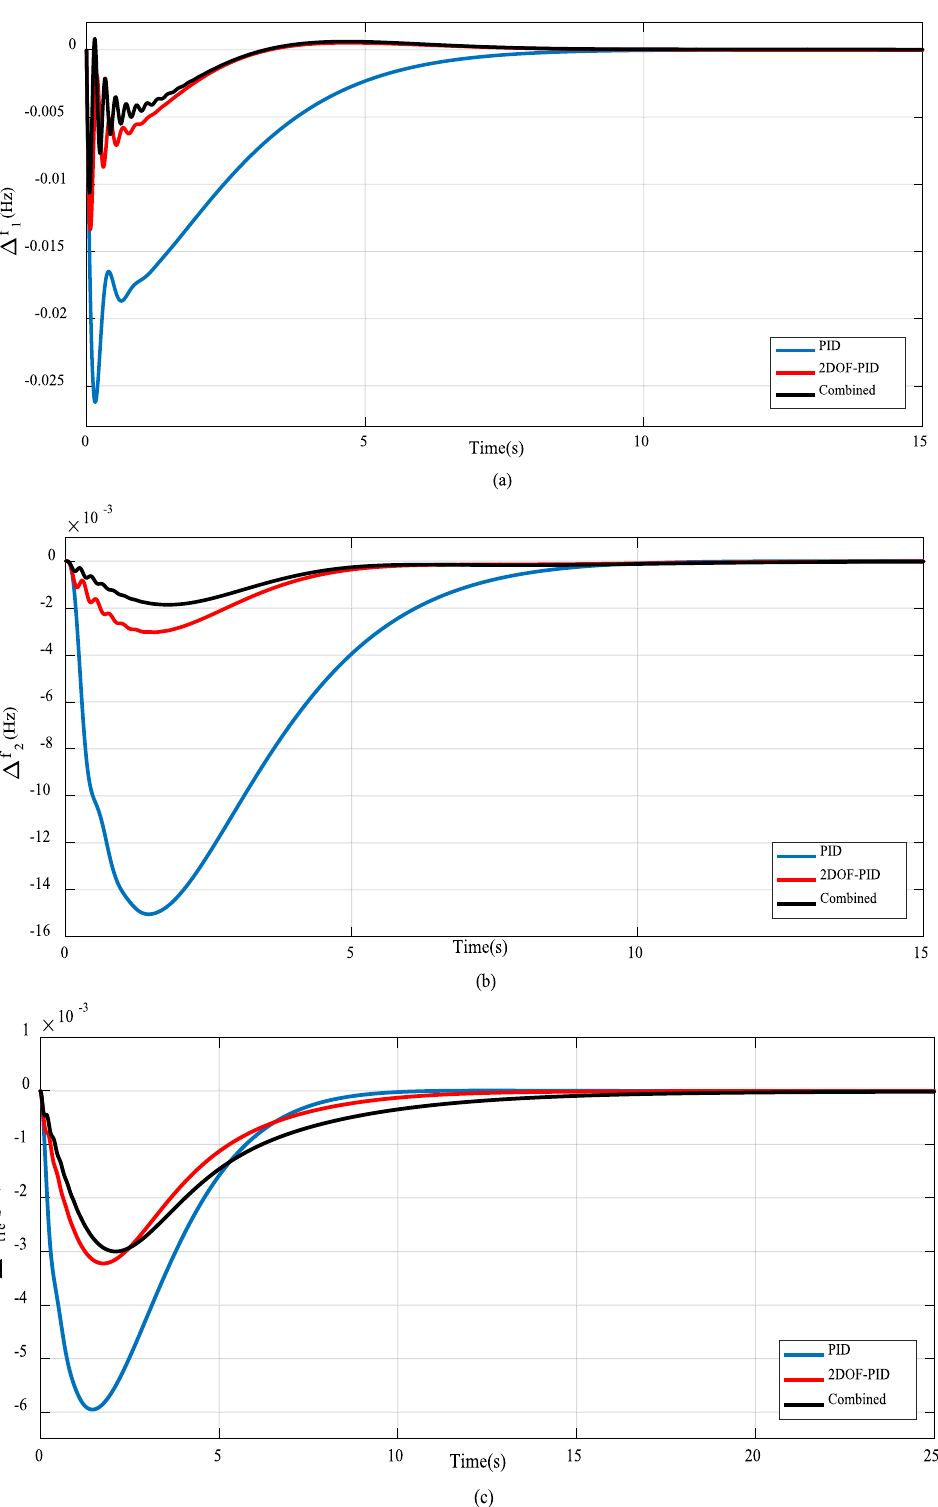
Fig. 5 Improvement in response with the combined controller when the load in area I changes without wind integration. a Area 1 frequency change; b area 2 frequency change; c tie line power